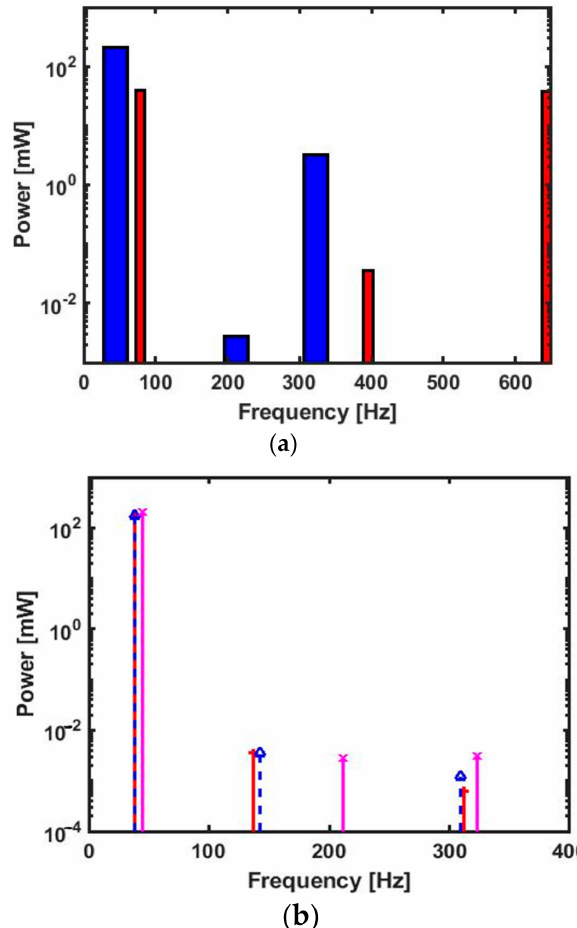
Figure 16. The output power for the first three resonant modes: ( a ) the unoptimized structure (red narrow bars) and the structure based on triplet 5 from Table 4 (blue wider bars); ( b ) the structures based on the triplet 2 (red solid lines with + on the top), 3 (blue dashed lines with triangle on the top), and 5 (solid magenta line with an x on the